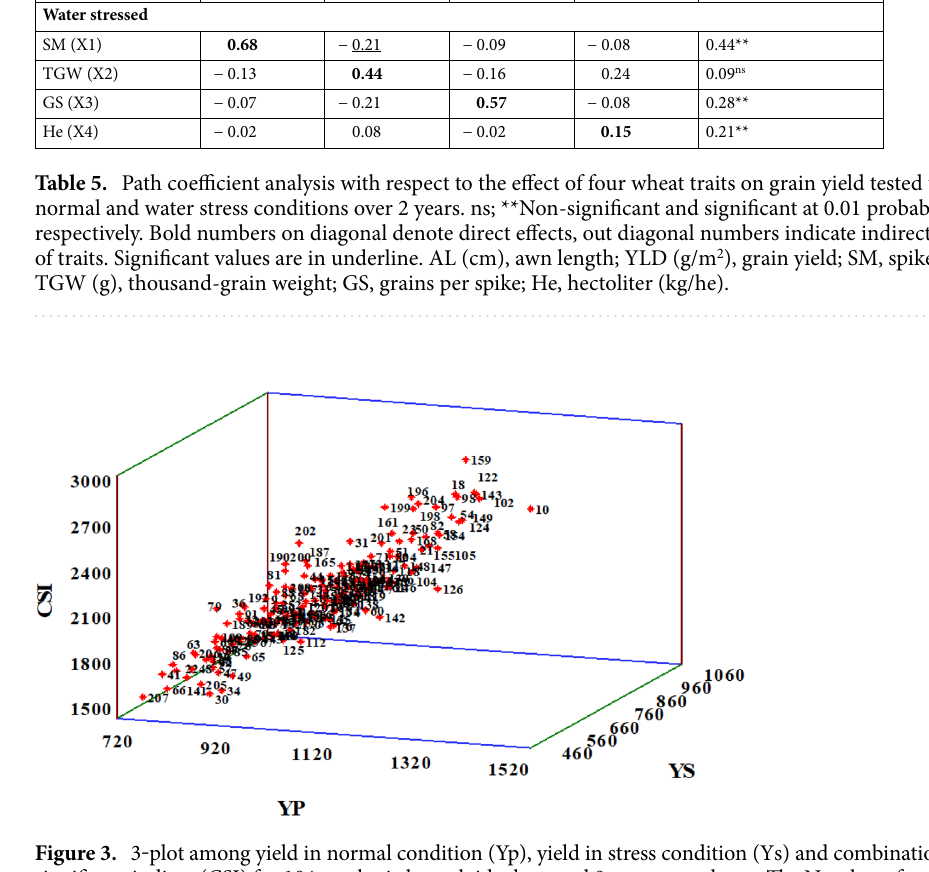
Figure 3. 3 ‐ plot among yield in normal condition (Yp), yield in stress condition (Ys) and combination of significant indices (CSI) for 184 synthetic hexaploid wheat and 8 common wheats. The Number of genotypes is according to the first column (Genotype code) in table